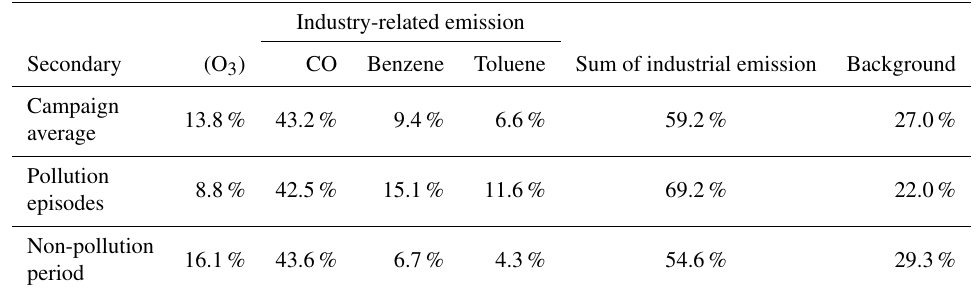
Table 3. Relative contributions (%) of different sources to the observed HCHO calculated using the multiple linear regression model. Pollu- tion episodes are defined as periods when HCHO concentration was higher than the campaign average, i.e.,